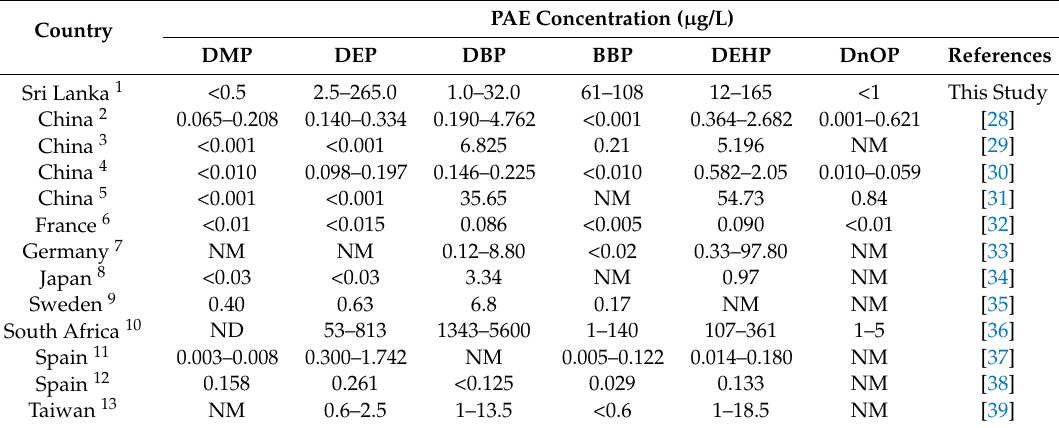
Table 4. Comparison of average levels of PAEs of watercourses in different